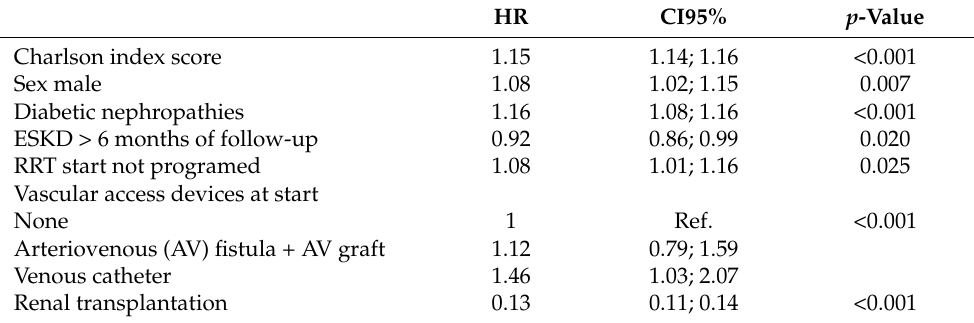
Table 5. Multivariate Cox regression model of prognostic factors in RRT patients in